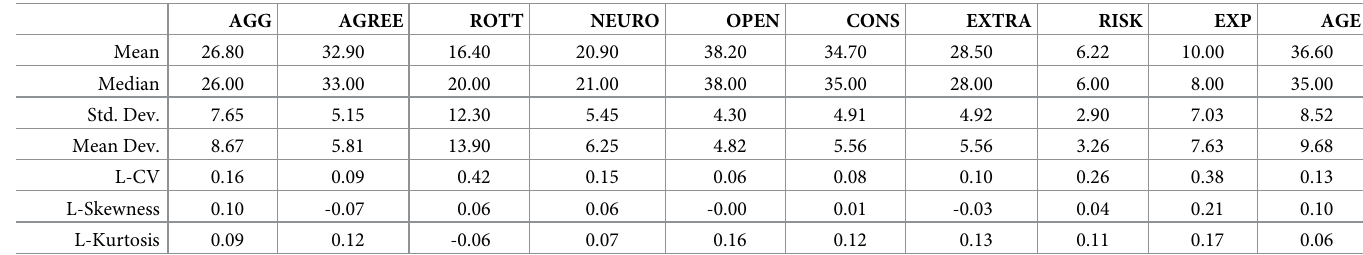
Table 1. Summary statistics.